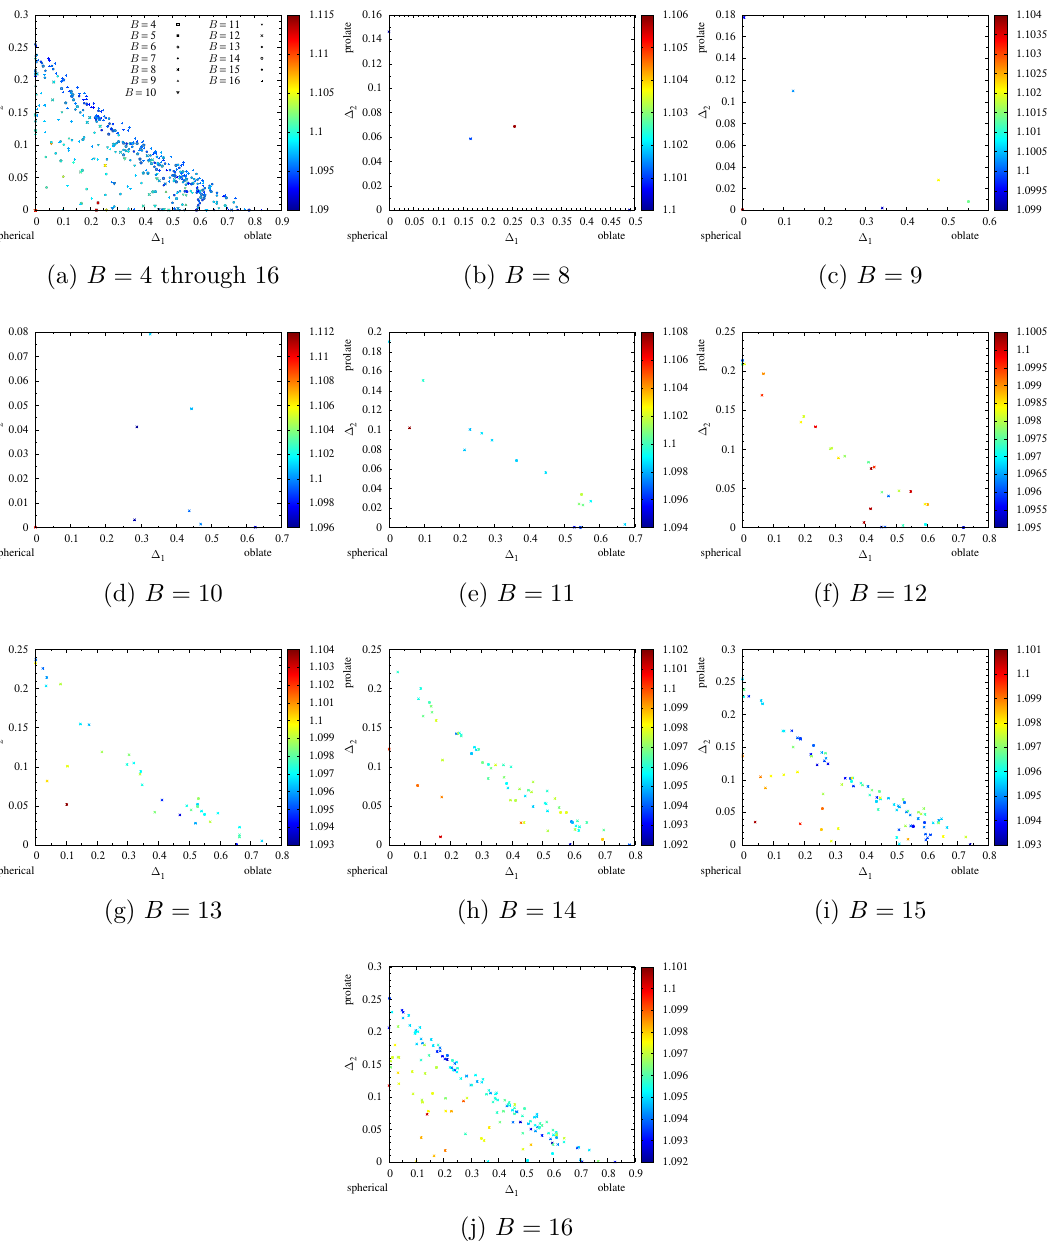
Figure 16. Oblacity/Prolacity/Sphericity of solutions versus normalized energies (cid:15) . The color represents the energy: high and low energy solutions are plotted in red and blue,